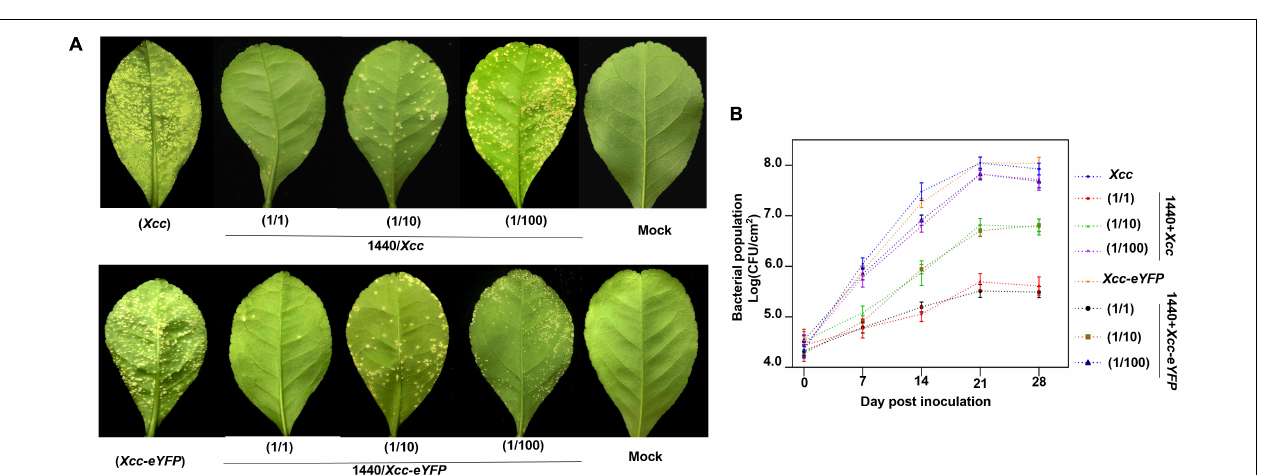
FIGURE 7 | The screening and evaluation process of Xcc- antagonistic bacterial strain. (A) Timelines of screening and evaluation processes of Xcc -antagonistic bacterial strains. (B) The antibacterial activity of the extraction was measured using the agar well diffusion assay. M, methanol control; 1440, ethyl acetate extract of antagonistic bacteria 1440. N: Negative control, ethyl acetate extract of Agrobacterium strain EHA105. All assays were repeated three times with similar results.